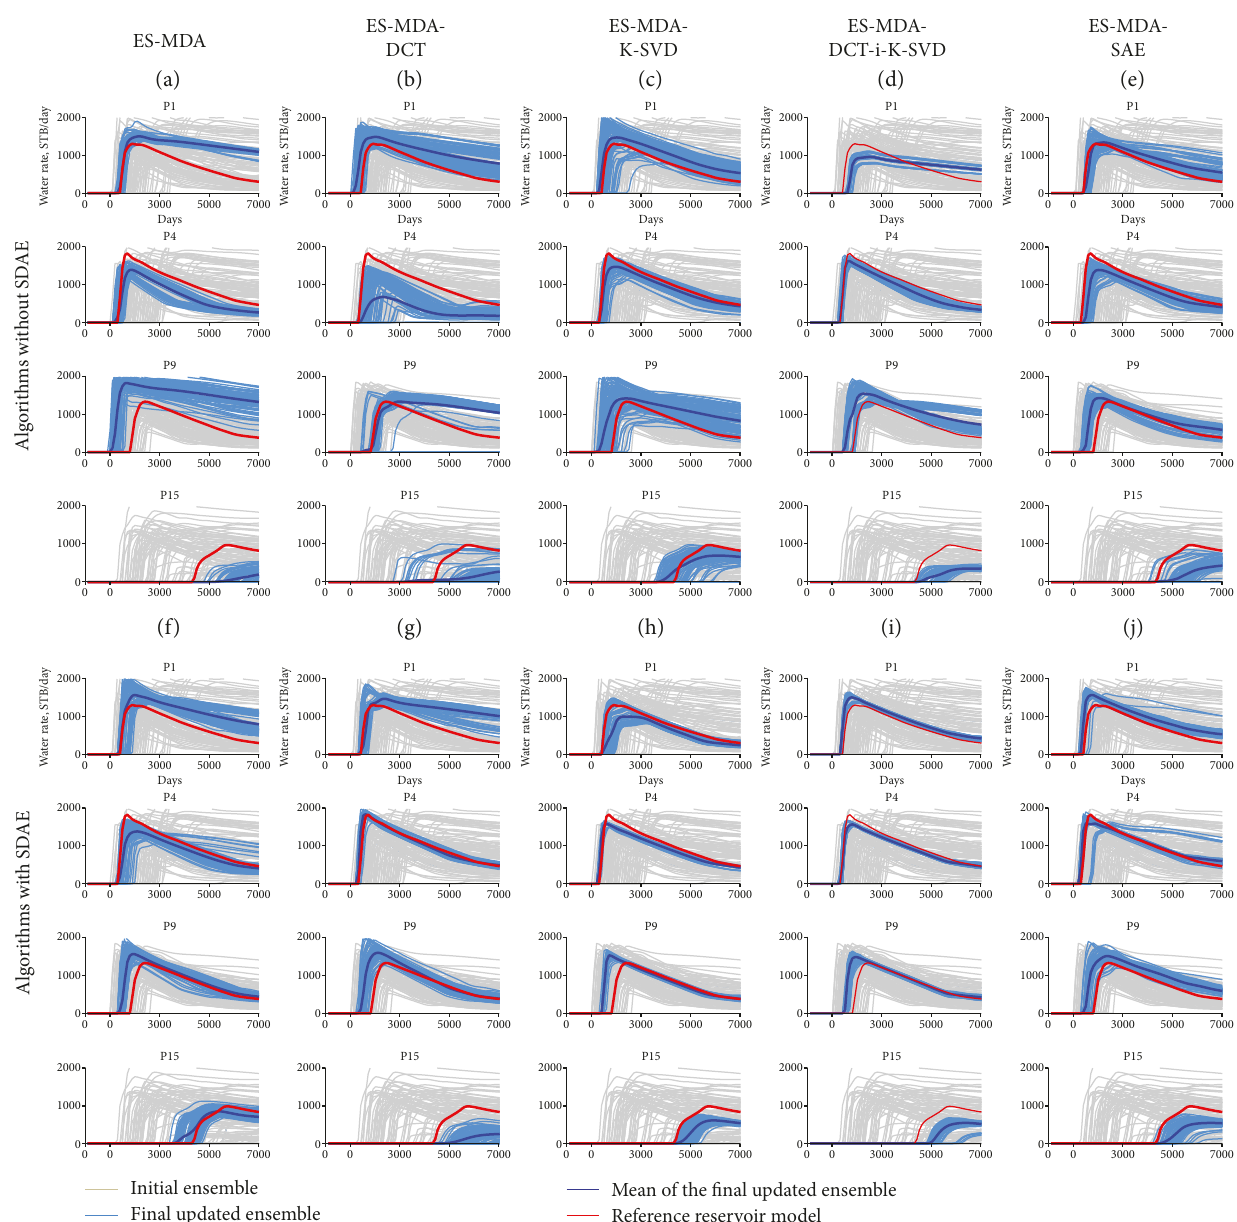
Figure 13: Pro fi les of water production rate at the four wells (P1, P4, P9, and P15) obtained by executing the ten ES-MDA algorithms. The latter fi ve algorithms from (f) to (j) are the algorithms coupled with